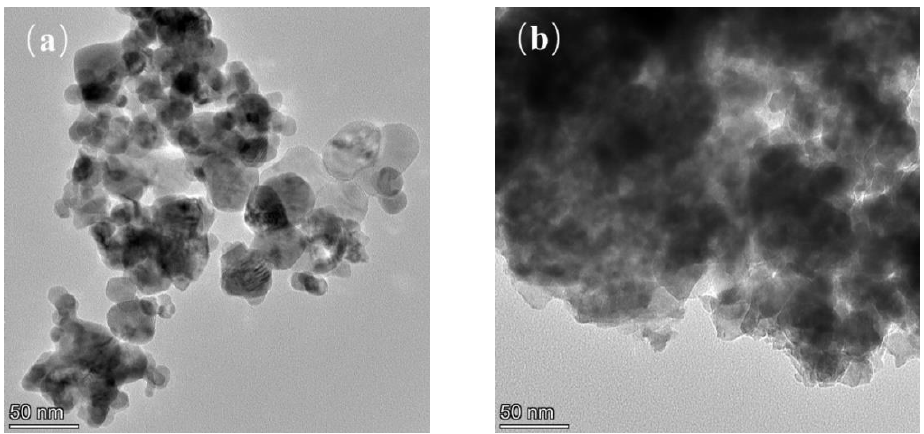
Figure 10. TEM images of Mg1Zr2-HT-used ( a ) and Mg1Zr2-CP-used ( b ). Compares the deconvoluted Mg 1s, Zr 3d, and O 1s XPS spectra of fresh and used Mg1Zr2-HT. The relative abundances of the Mg 1s, Zr 3d, and O 1s of the samples from Figure S4 showed that the content of the oxygen vacancy decreased from 26.5% to 23.1% and the content of the chemisorbed oxygen species increased from 1.1% to 3.9%, respectively, indicating that irreversible deactivation was caused. As can be seen from Table 4 that the Mg1Zr2-HT-used catalyst has a larger specific